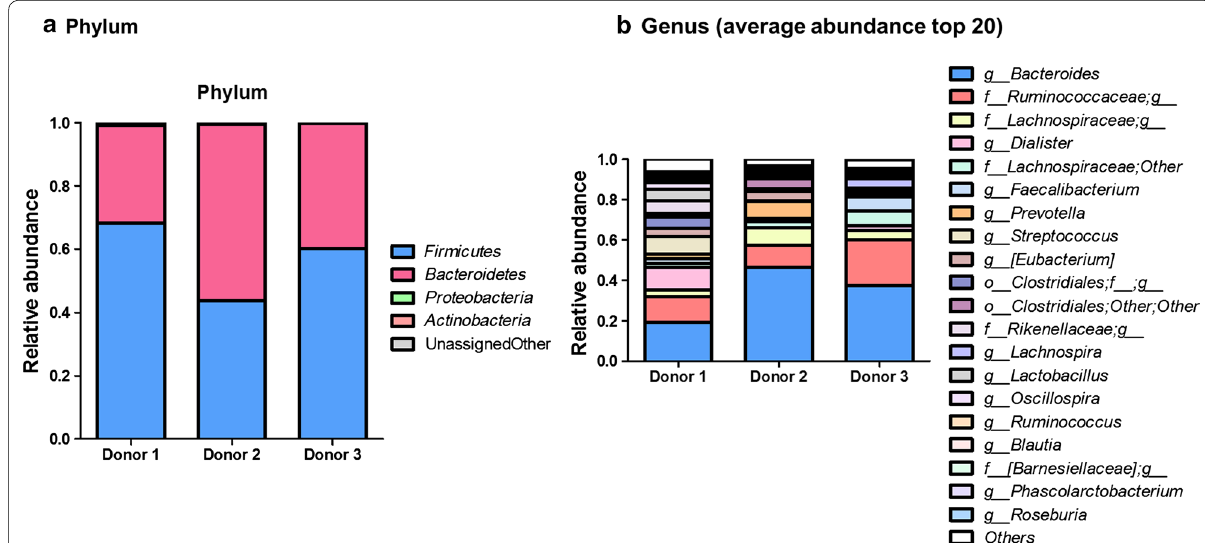
Fig. 2 Baseline fecal microbial compositions of each donor, including the relative abundance of phyla ( a ) and the 20 most abundant genera ( b )